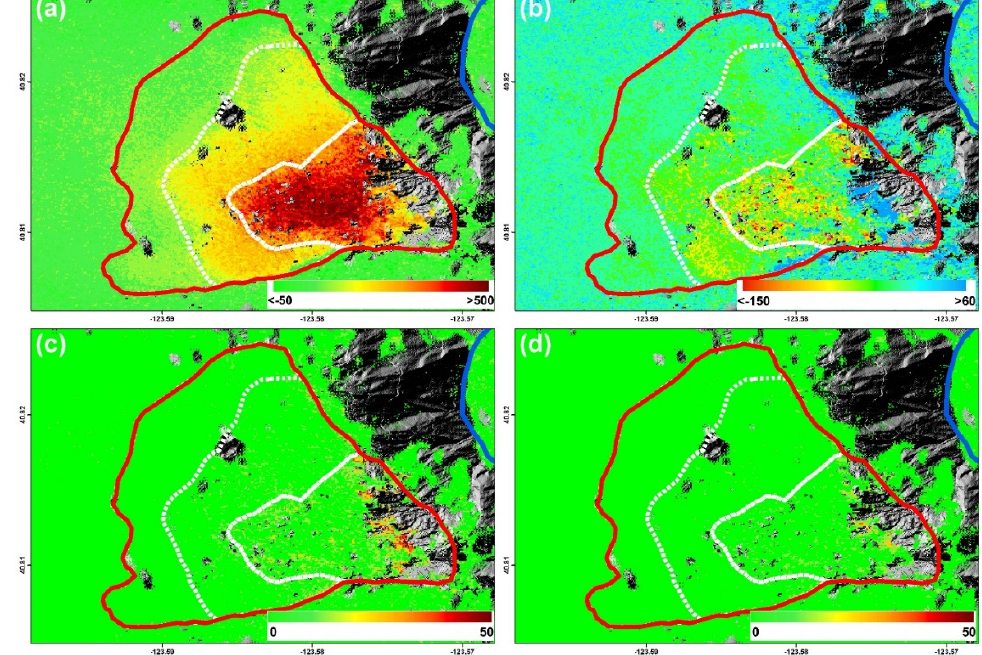
Figure 7. Two-dimensional deformation rate maps from 2015 to 2017 calculated from ascending and descending SAR datasets (unit: mm/yr): ( a ) the east–west deformation; ( b ) the vertical deformation; ( c ) the standard deviation (STD) of the estimated east–west deformation rate; and ( d ) the standard deviation (STD) of the estimated vertical deformation rate. The red polygon shows the active landslide, while the white line represents the boundary of different sections inferred by the InSAR- derived deformation pattern and the compressional morphologic features.